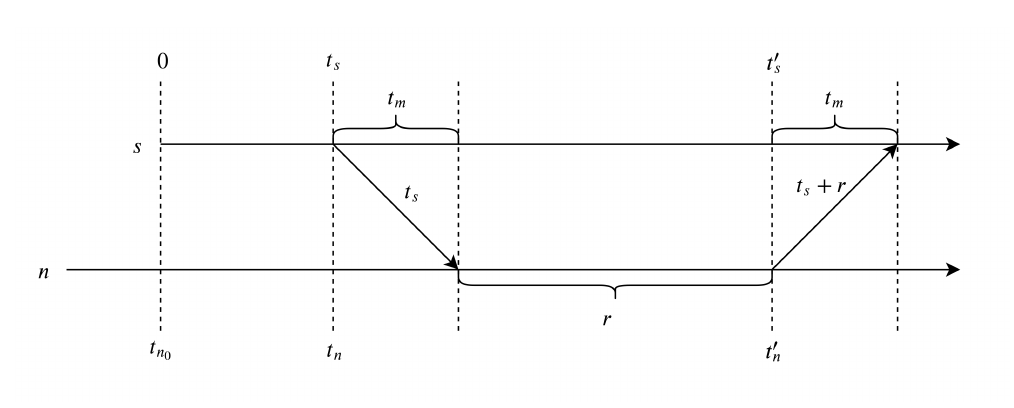
Figure 2. The synchronization scheme utilized in this